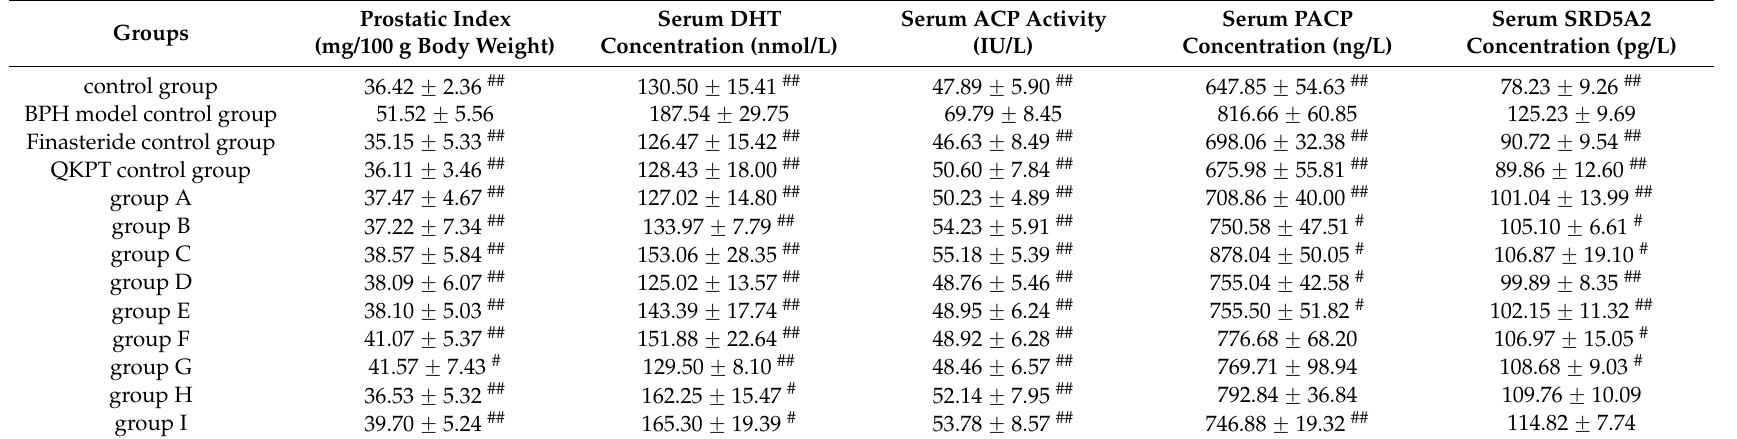
Table 3. Effect of aqueous extracts of S. stolonifera on the serum acid phosphatase (ACP) activity, prostate index (PI), and the concentration of serum dihydrotestosterone (DHT), prostatic acid phosphatase (PACP) and SRD5A2 in a castration and testosterone-induced mice model of benign prostatic hyperplasia